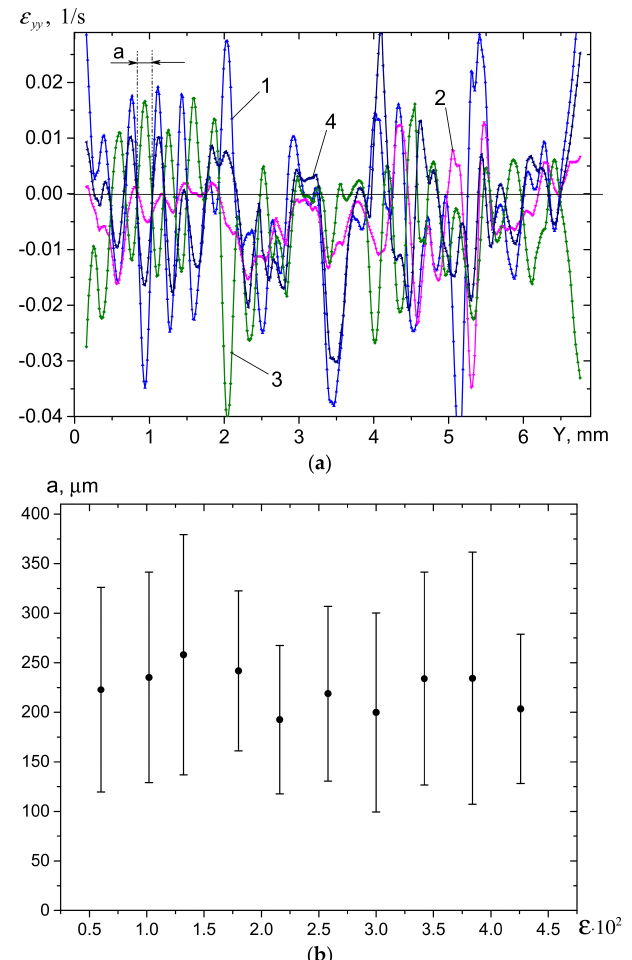
. Figure 8. In situ distribution of ε yy ( Y , X = X m /2 ) values ( a ) and the mean block size evolution with